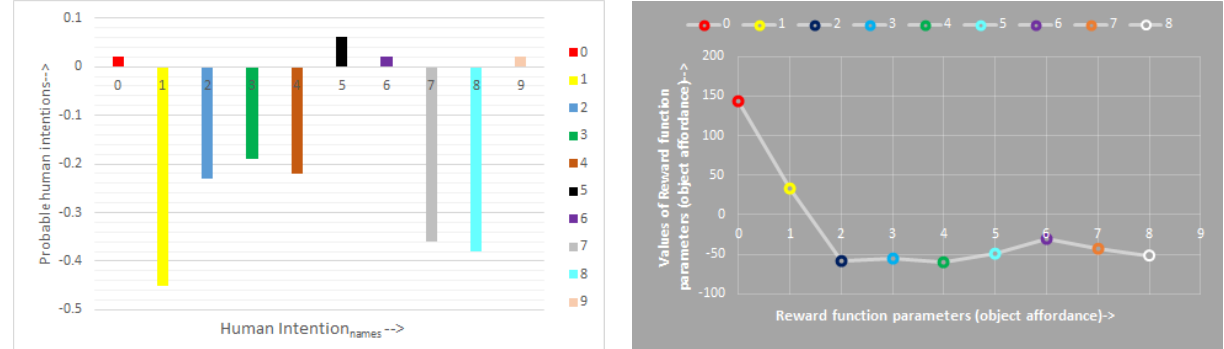
Figure 7: This figure is similar to Figure 4. It consists of one pair of graphs originated from a particular category of demonstrations of CAD- 120 dataset. However, this category is different from demonstrations explained in the previous figures (Figure 4, Figure 5 and Figure 6). In Figure 4a and Figure 4b, the meaning of the legends (markers) have been provided in the figure itself. The legends in the left hand side of this figure carries the same meaning as annotated in Figure 4a. Similarly, the meaning of the legends in the right hand side of this figure carries the same meaning as annotated in Figure